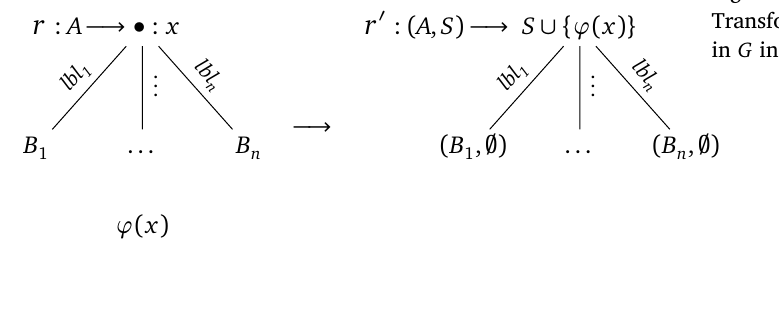
Figure 4: Transformation of a rule in G into rules of G